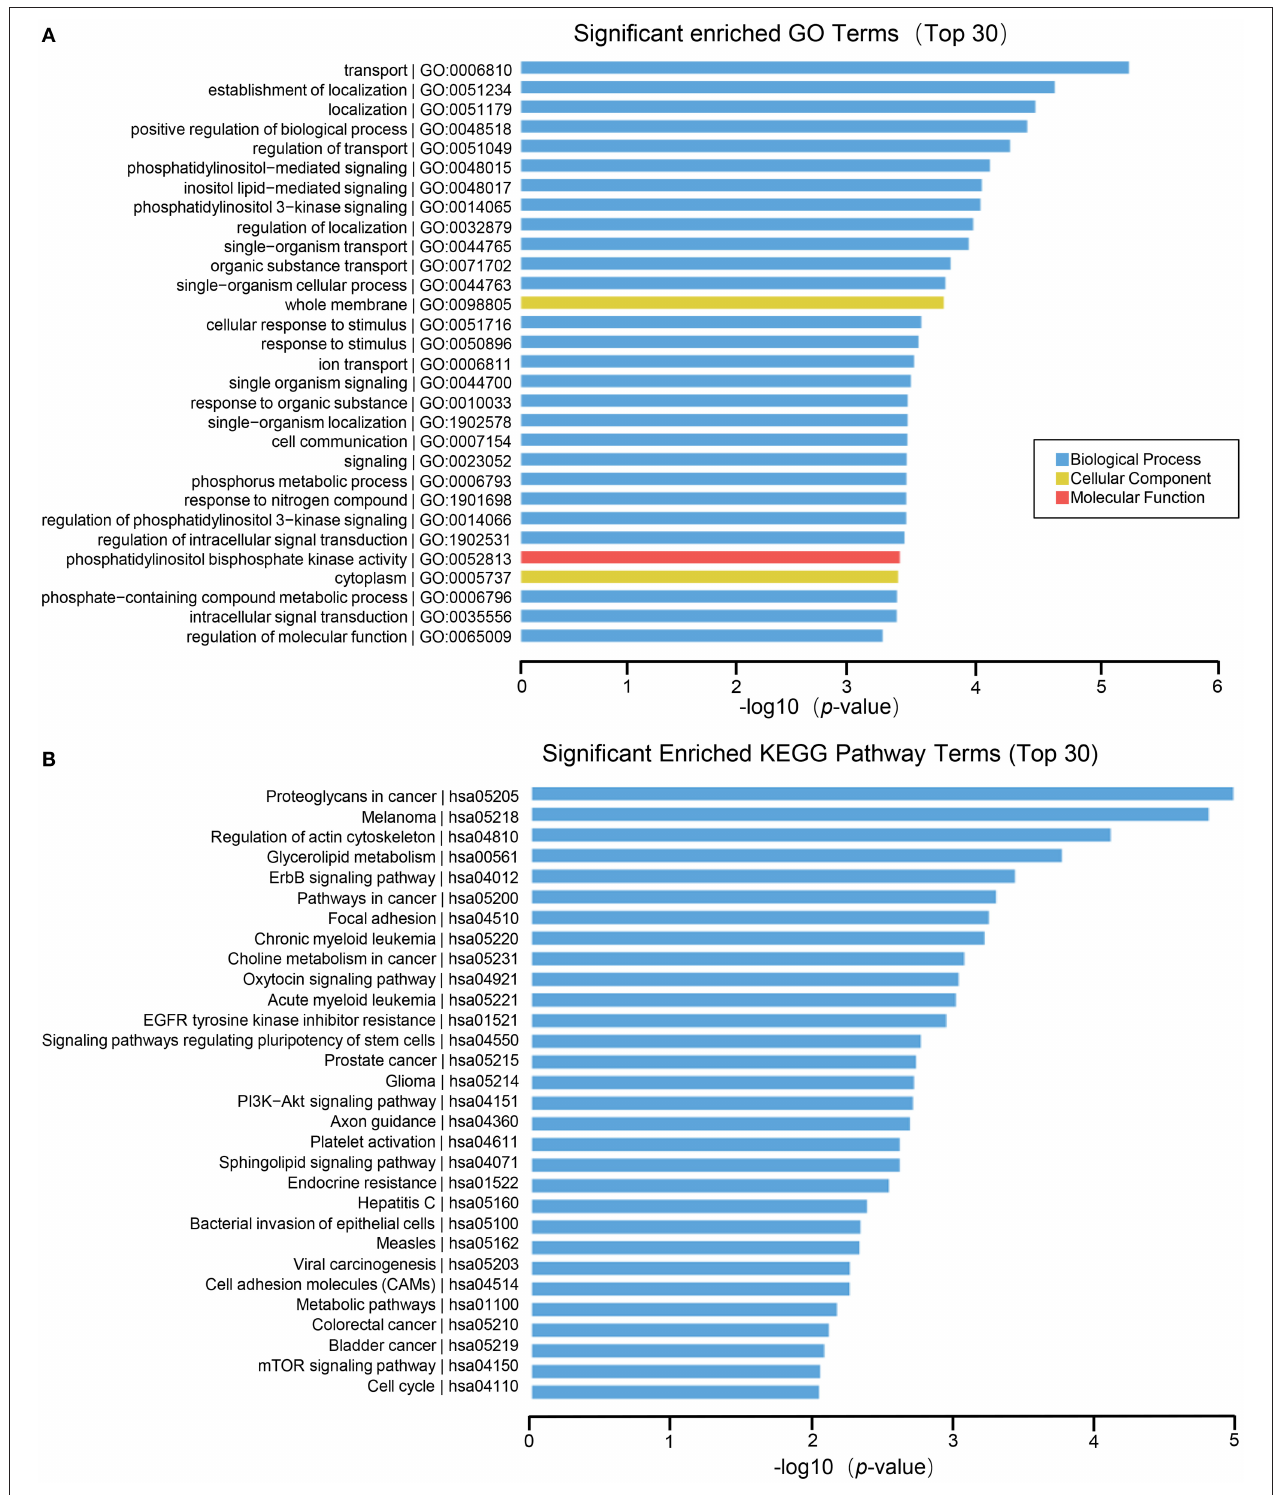
FIGURE 6 | GO and KEGG pathway analysis on the results of miRNAs. (A) Gene ontology analysis. Top 30 GO terms for the difference in miRNA between HT group and non-HT group. (B) KEGG pathway analysis. Top 30 pathways for the difference in miRNA between HT group and non-HT group.